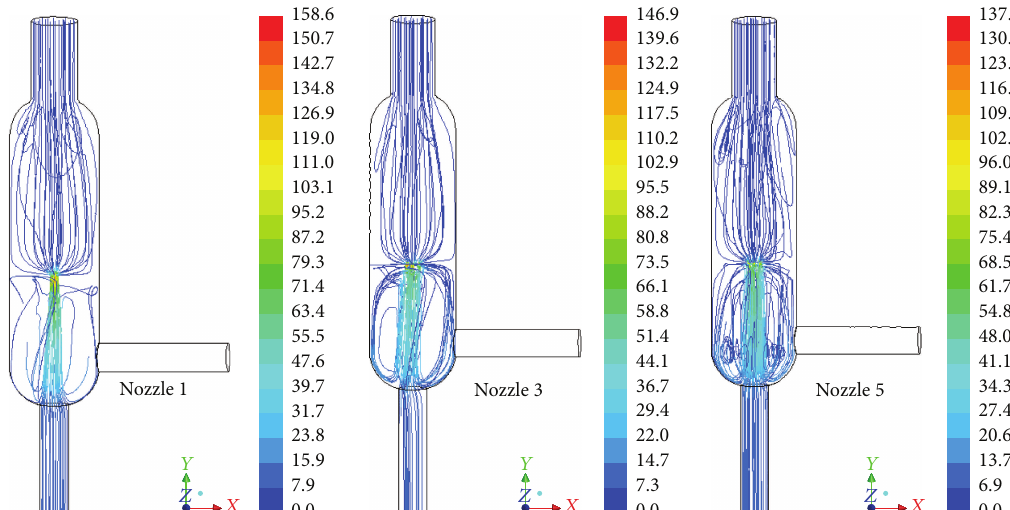
Figure 24: Path lines of liquid for nozzles 1, 3, and